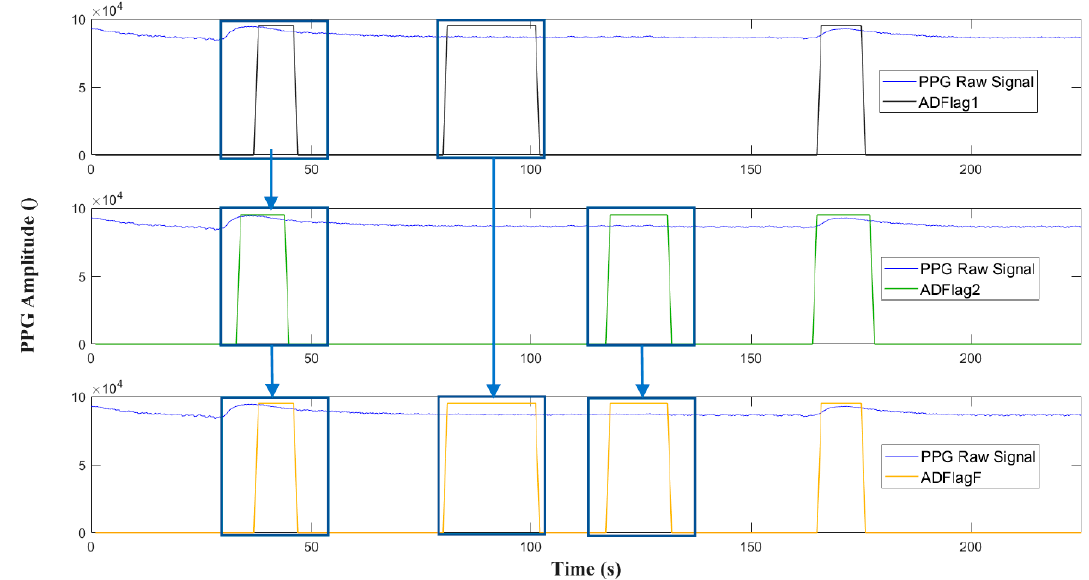
Figure 14. OR operation between ADFlag1 and ADFlag2 with ADFlagF as output.